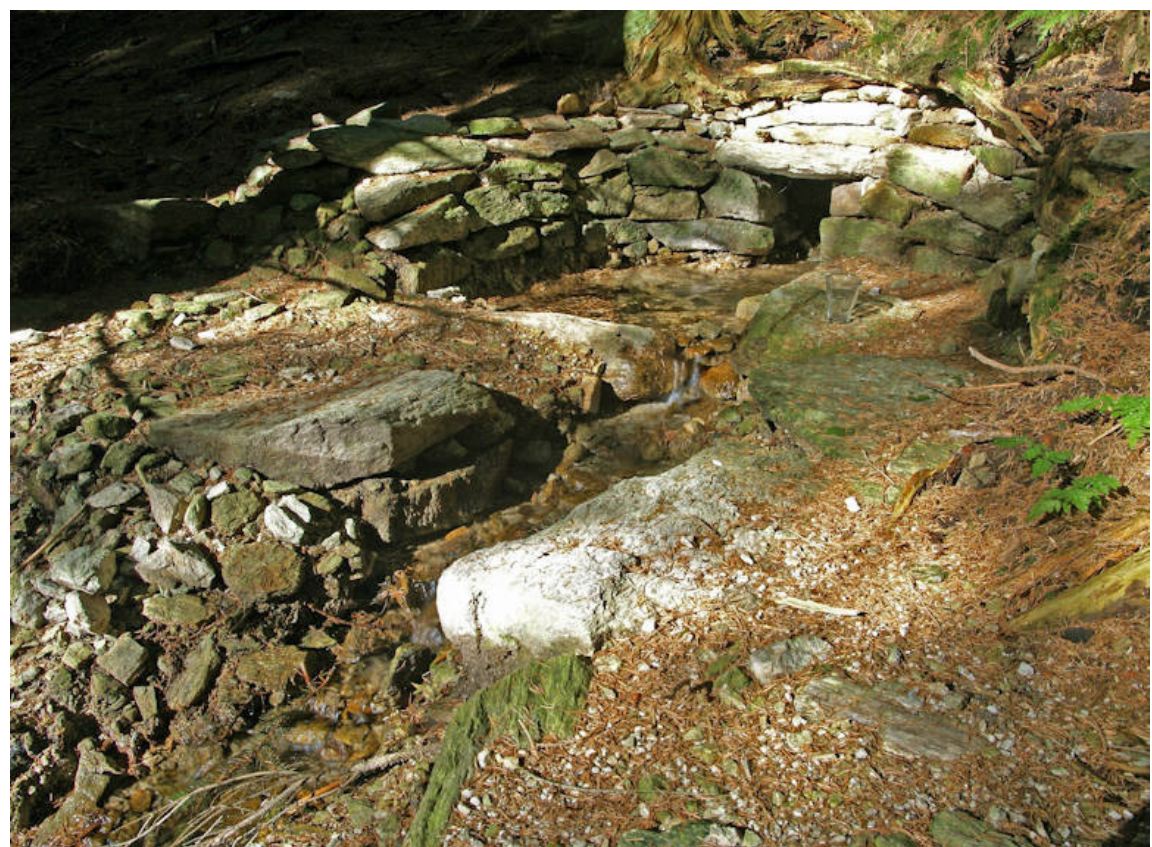
Figure 7. Jakub ů v spring in St ř íbrnice. Photo by Ji ř í Kamp, June 2006, with permission. Figure 7. Jakub˚uv spring in Stˇr í brnice. Photo by Jiˇr í Kamp, June 2006, with